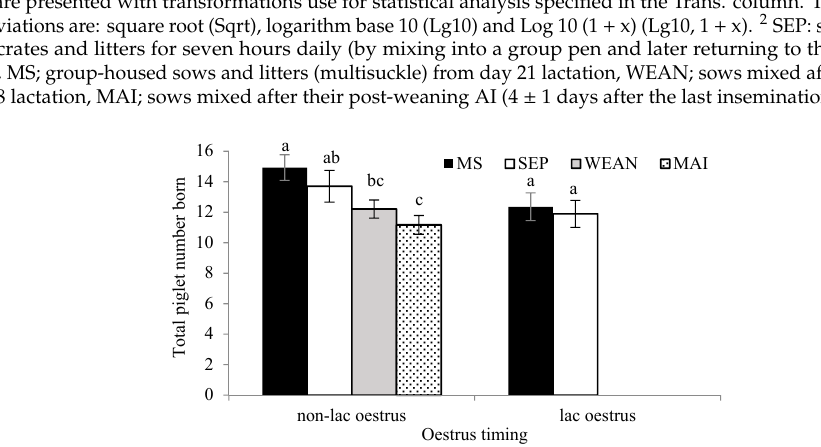
Figure 4. The total number of piglets born to sows which were mated in lactation or mated outside of lactation 1,2 . a,b,c Means with di ff erent superscripts di ff er ( p < 0.05). 1 Mean and SEM presented. 2 SEP: sow separation from crates and litters for seven hours daily (by mixing into a group pen and later returning to their crates and litters, MS; group-housed sows and litters (multisuckle) from day post-weaning AI (4 ± 1 days after the last insemination). “lac”: